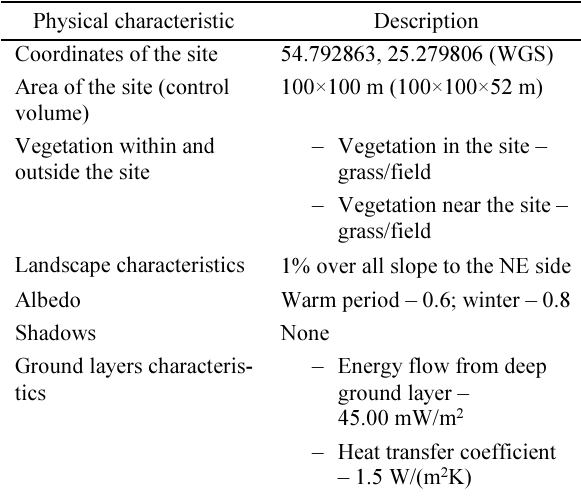
Table 1. Building site’s physical